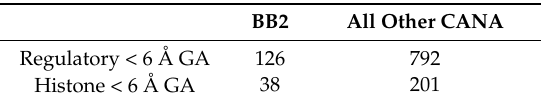
Table 4. An example of contingency table comparing dinucleotides in groups Regulatory < 6 Å and Histone < 6 Å for the BB2/GA association (incidences in Figure 1a,b). The table is constructed to measure the significance of the CANA preferences for the GA